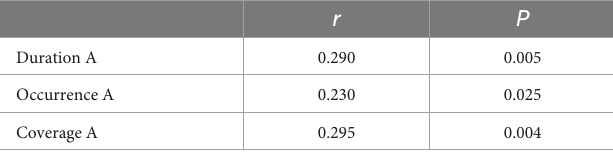
TABLE 2 Correlation for microstate parameters and MOAS